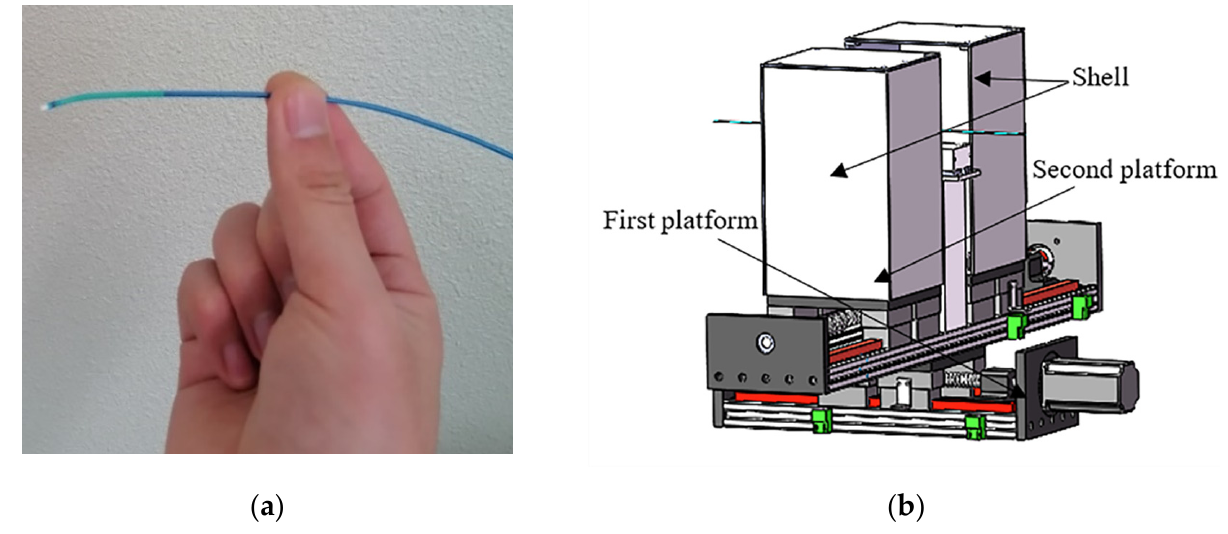
Figure 4. ( a ) Traditional manual operation; ( b ) proposed novel slave manipulator.